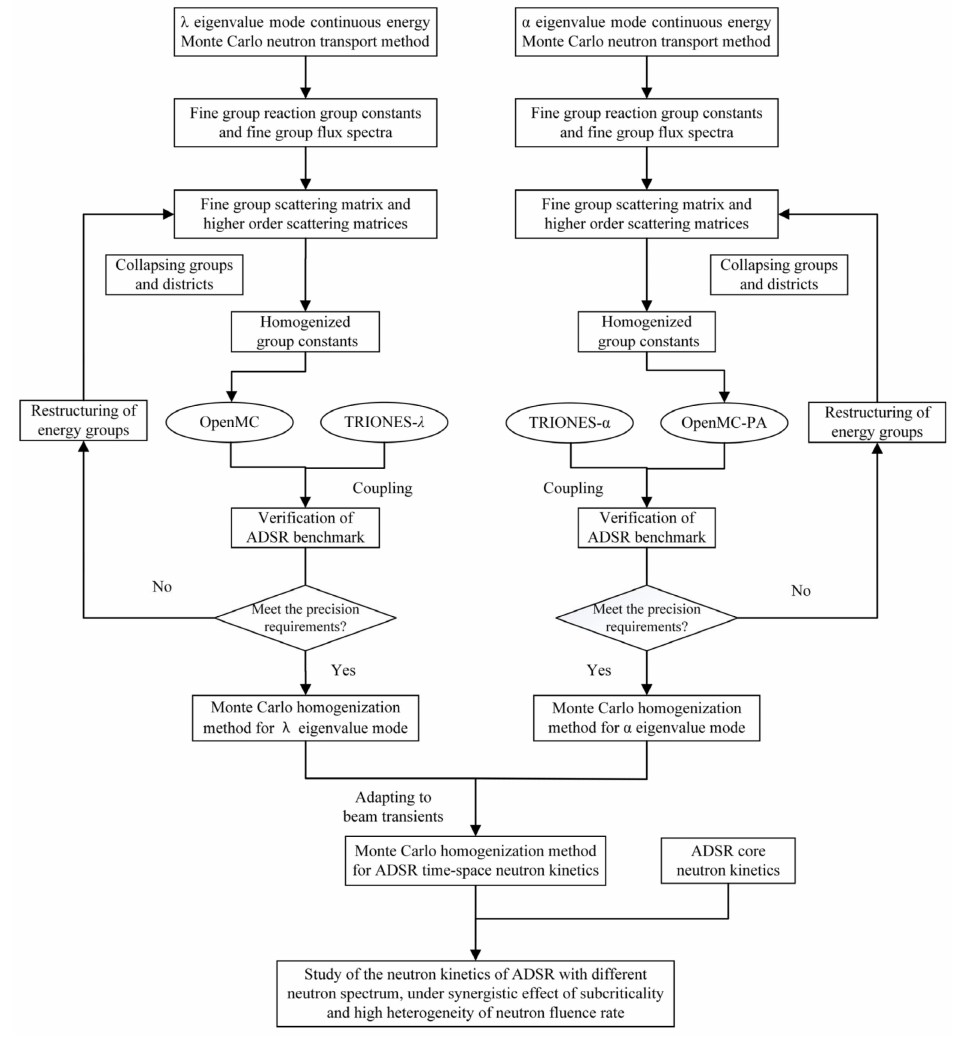
Figure 2. Flow chart of the entire calculation